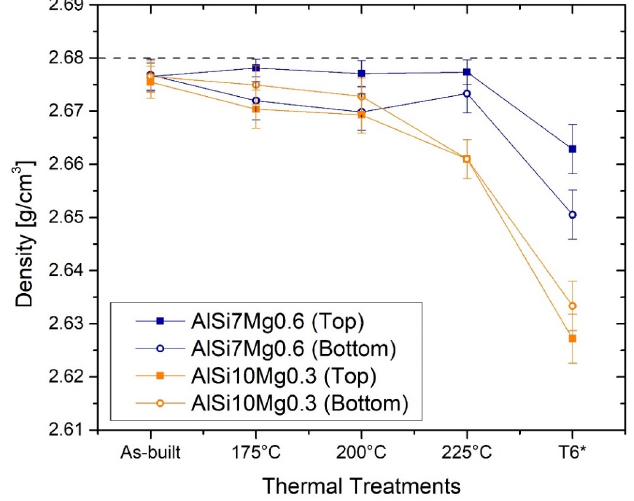
Figure 4. Trends of the density values related to top and bottom of the AlSi7Mg0.6 and AlSi10Mg0.3 samples before and after the direct aging at 175, 200, 225 °C for 8 h and the T6*. The values related to the AlSi10Mg0.3 samples were presented and discussed in [18]. the AlSi10Mg0.3 samples were presented and discussed in [18].